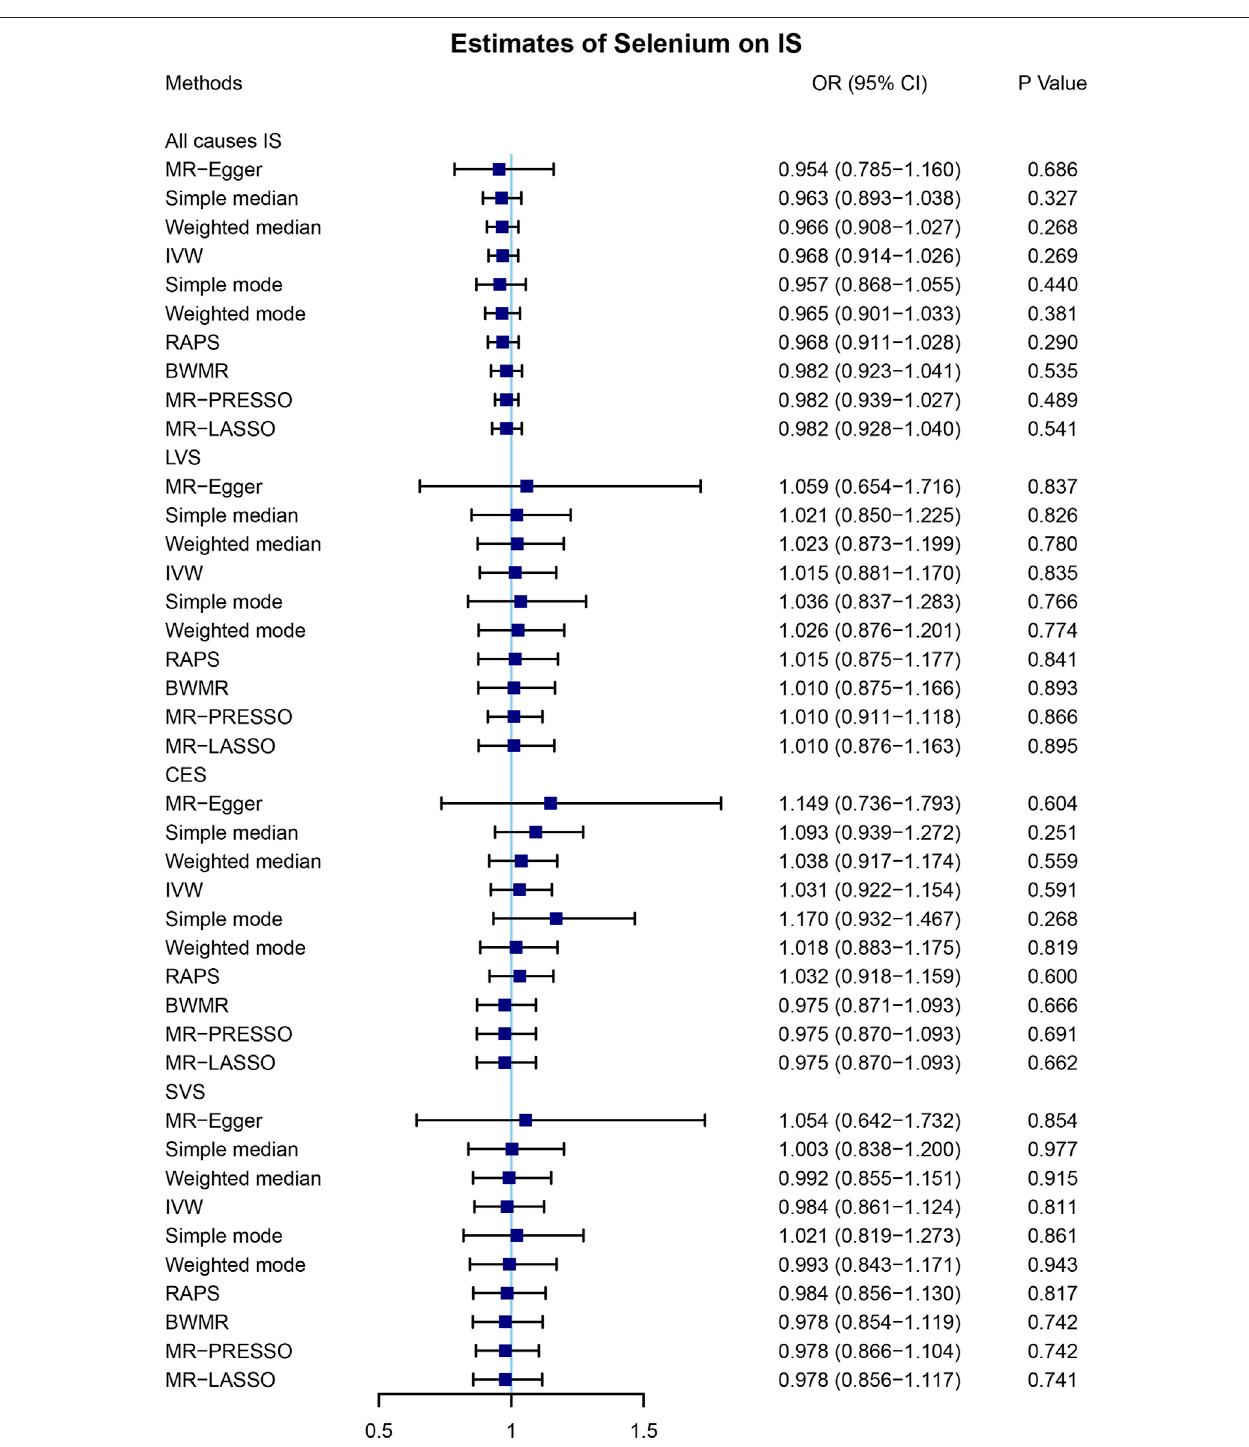
FIGURE 2 | Mendelian randomization analysis of the causal effects of selenium levels on ischemic stroke. A total of 4 SNPs signi fi cantly associated with selenium levels were obtained. MR, Mendelian randomization; IS, ischemic stroke; SNP, single-nucleotide polymorphism; OR, odds ratio; CI, con fi dential interval; IVW, inverse variance-weighted; RAPS, robust adjusted pro fi le score; BWMR, Bayesian weighted Mendelian randomization; MR-PRESSO, Mendelian randomization pleiotropy residual sum and outlier; MR-LASSO, Mendelian randomization least absolute shrinkage and selection operator; LVS, large-vessel atherosclerosis stroke; CES, cardio-embolic stroke; SVS, small-vessel occlusion